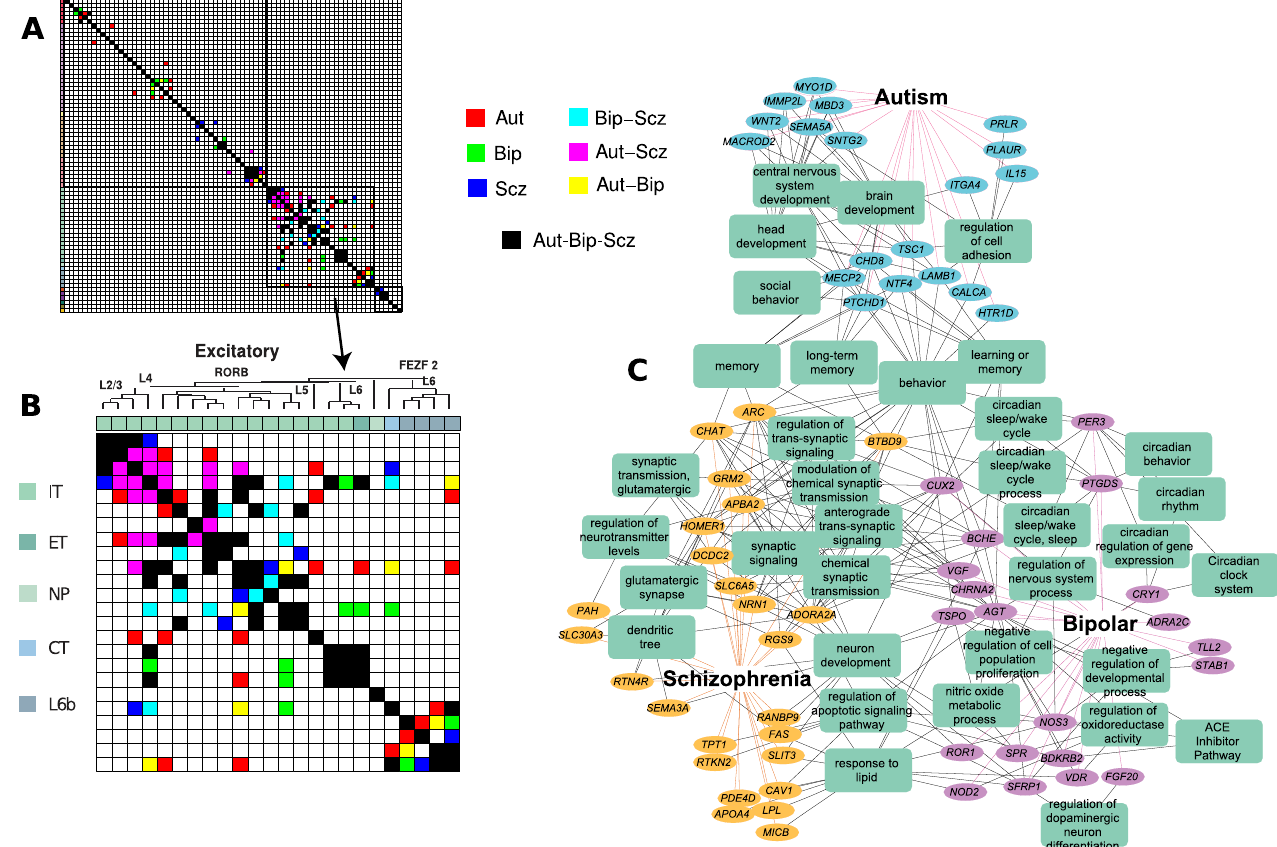
Fig 4. Cell type profile of autism, bipolar, and schizophrenia in human MTG. (A) Significant cell type-specific covariation of gene expression across MTG for 3 major psychiatric disorders ( Methods ). All 75 cell types from [15] with magnification of 24 excitatory types shown in (B), color coded by disease combinations. Autism ( Aut , cyan), bipolar disorder ( Bip , purple), and schizophrenia ( Scz , yellow) show interactions unique to these diseases, Aut-Bip (blue), Aut-Scz (green), and Bip-Scz (red) unique to pairs, Aut-Bip-Scz (black) for all. Excitatory cell types ( IT , ET , NP , CT , L6b ) and dendrogram taxonomy from [15]. (C) Cell type-specific genes unique to excitatory interactions ( Aut , Bip , Scz ) from (B) and representative enriched biological processes and pathways. NN = non-neuronal. Underlying data for Fig 4 can be found in S1 and S7 Tables, and the data from S1 Data/Three_psychiatric_disorders. Raw data available at https://portal.brain-map.org/atlases-and-data/rnaseq under MTG SMART-seq(2018). Code available as a notebook at https://github.com/yasharz/human- brain-disease-transcriptomics. MTG, middle temporal